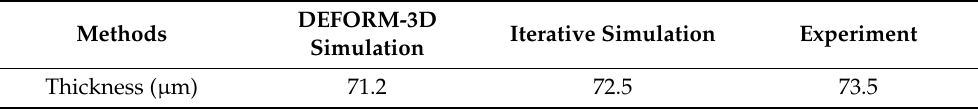
Table 5. Final machining thickness comparison among different methods.